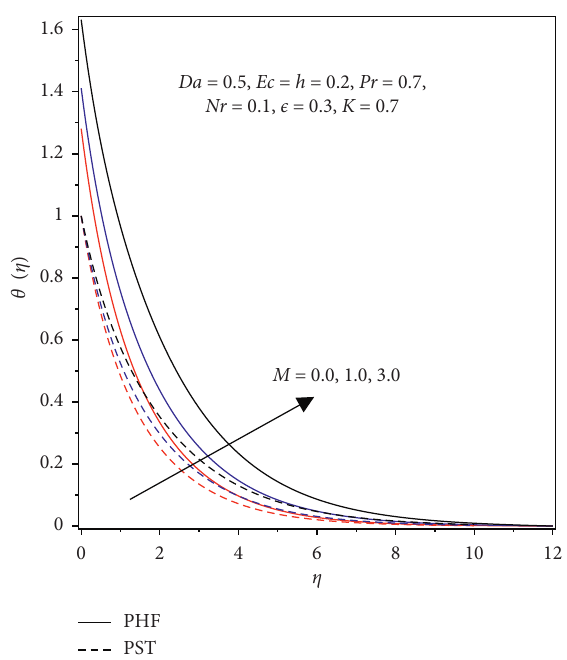
Figure 4: Magnetic field parameter M variation with temperature distribution.